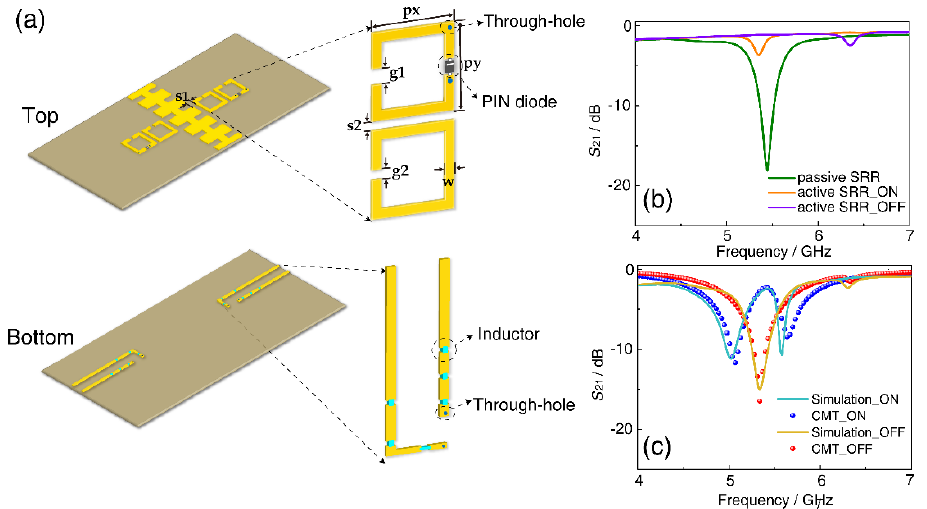
Figure 2. Schematic diagram and EIT-like transmission characteristics based on SSPP waveguide. ( a ) Top and bottom views of the proposed configuration, where the yellow part is metal and the brown part is dielectric substrate. ( b ) Transmission coefficients ( S 21 ) of SSPP waveguide loaded with single set of passive SRRs and active SRRs when the PIN diodes are in the ‘ON’ and ‘OFF’ states, respectively. ( c ) Simulated and theoretically fitted transmission coefficients ( S 21 ) of SSPP waveguide